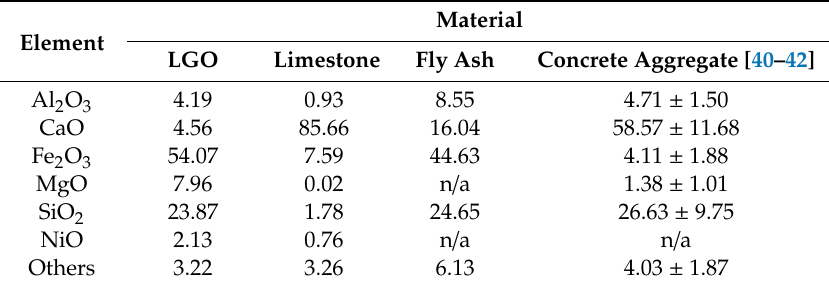
Table 3. Percentage of oxide composition of neutralizing agents. Material Element LGO Limestone Fly Ash Concrete Aggregate [40–42] Al 2 O 3 4.19